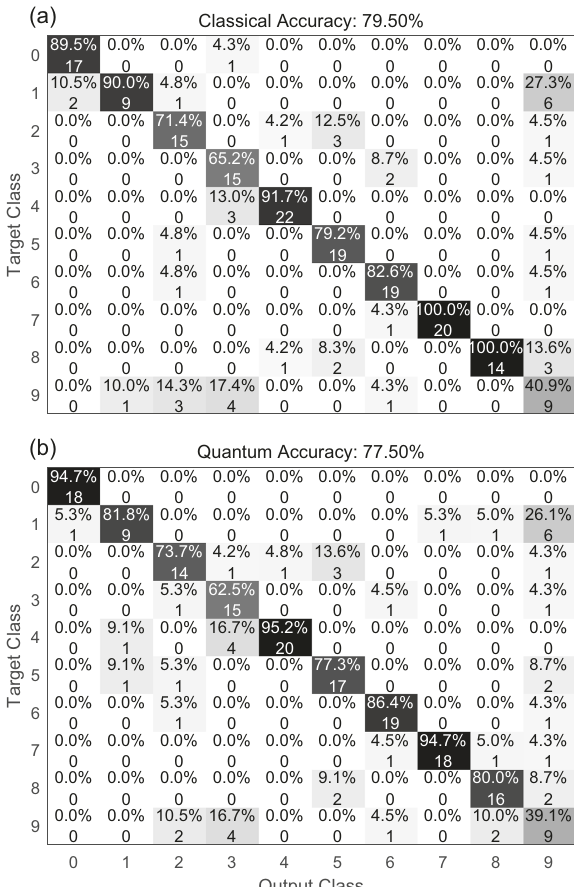
Fig. 5 Confusion matrices. Confusion matrices for MNIST classi fi ca- tion a from classical, and b quantum computer with 10 classes and 200 points after error